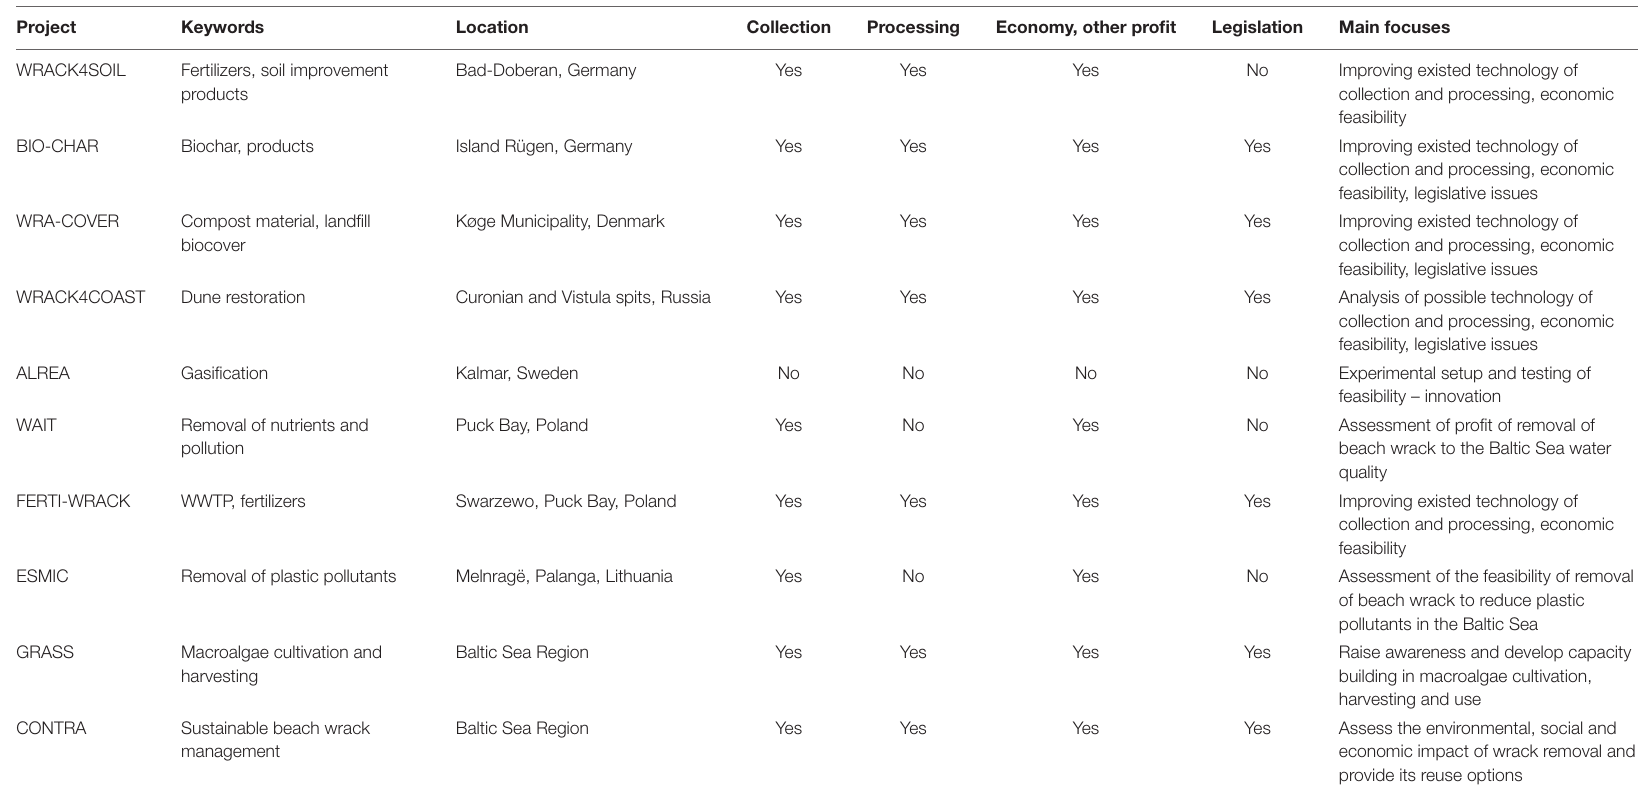
TABLE 7 | Case studies on beach wrack in the Baltic Sea